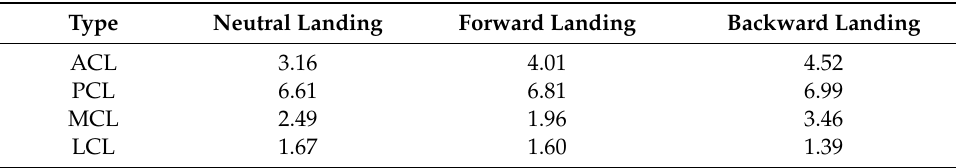
Table 1. The stresses of the ligaments in three cases.